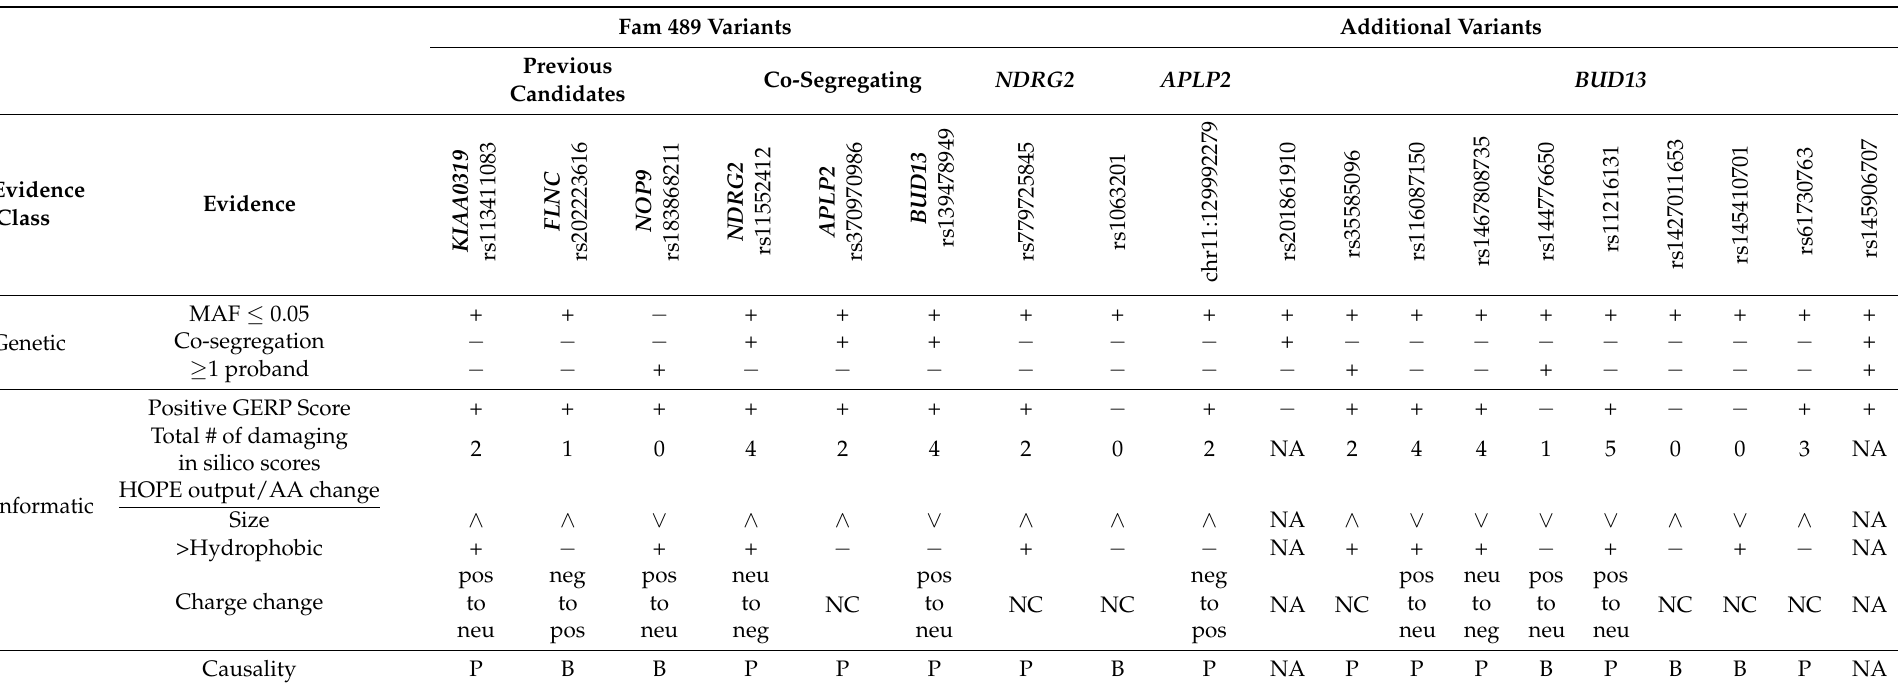
Table 5. Summary of evidence supporting causality of variants identified in family 489 and probands with